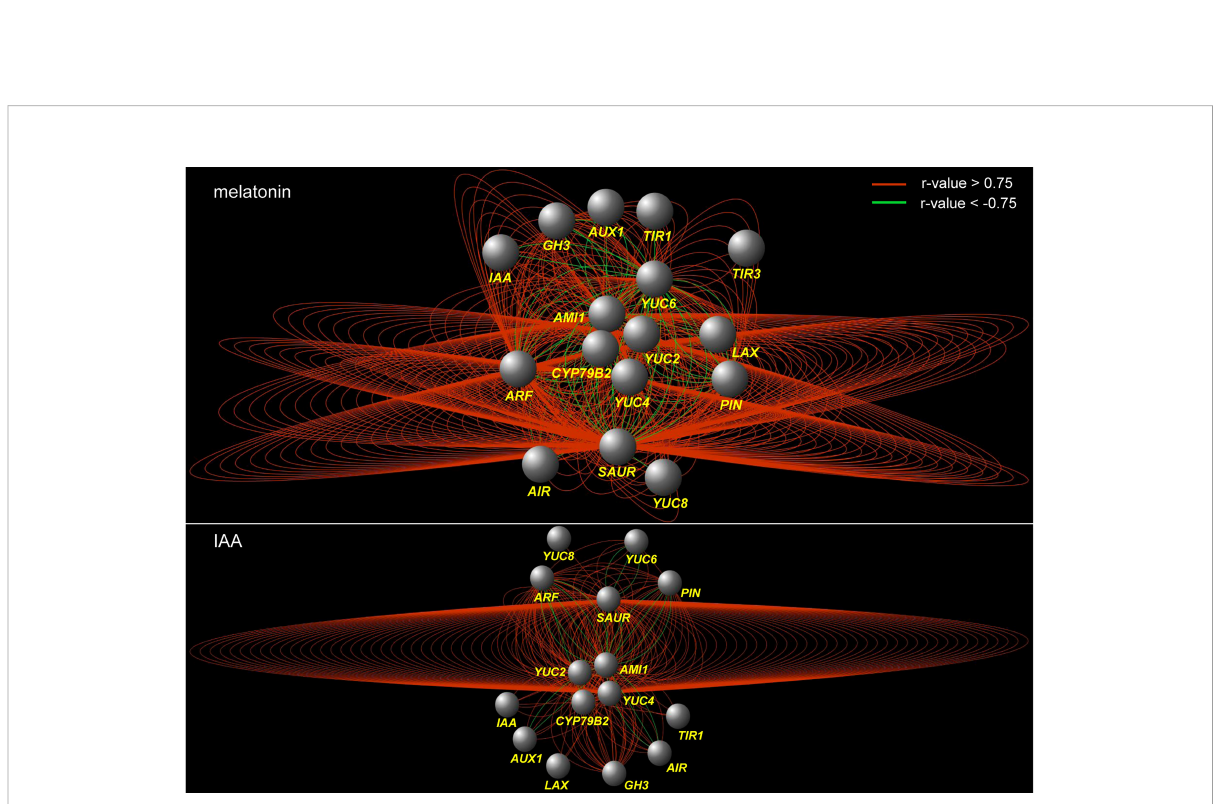
FIGURE 3 Co-expression network of the genes that are related to auxin biosynthesis and signaling pathways under melatonin and IAA treatments. The red edges indicate positive correlation (r > 0.75, FDR < 0.01), whereas the green edges indicate negative correlation (r < -0.75, FDR < 0.01). The correlation was calculated with ‘ pearson ’ method. The nodes indicate groups of genes which were listed in Table S4.